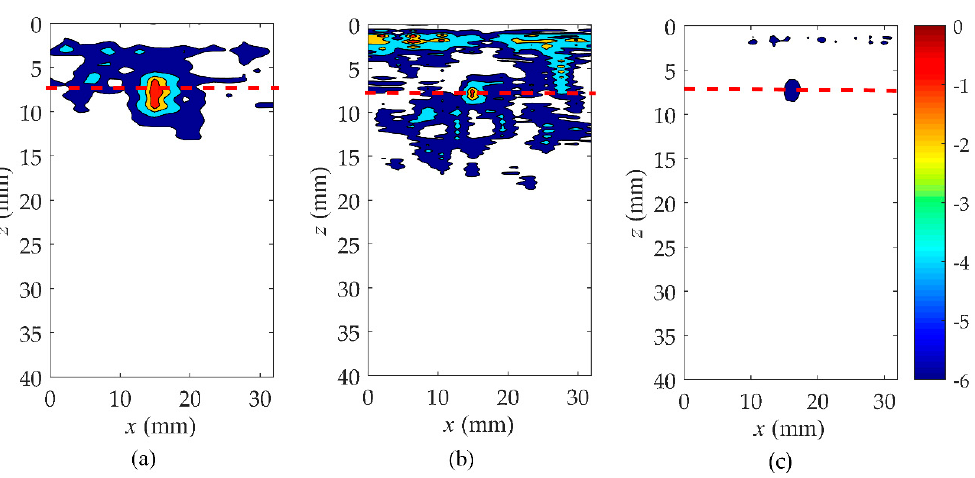
Figure 9. Comparison of point spread function in three cases in rail A. ( a ) Case one, ( b ) case two, ( c ) case three.